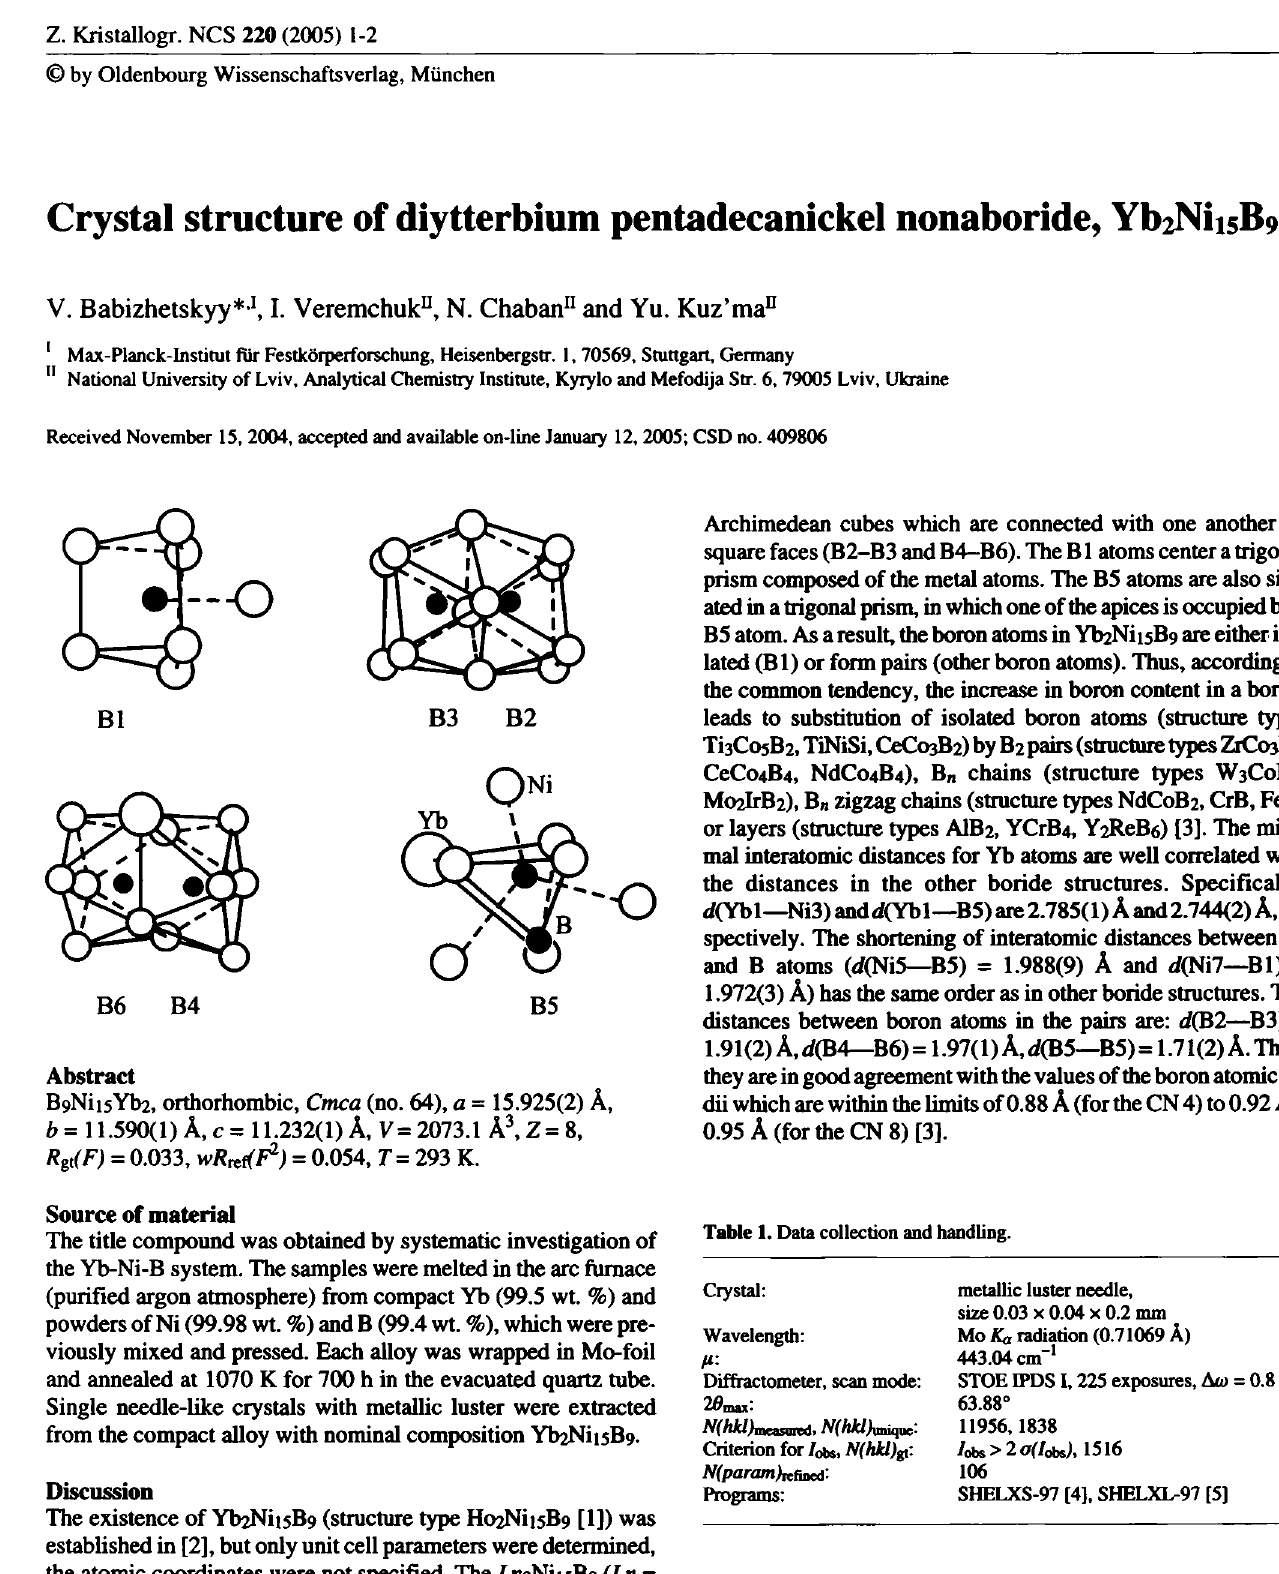
Table 1. Data collection and handling.